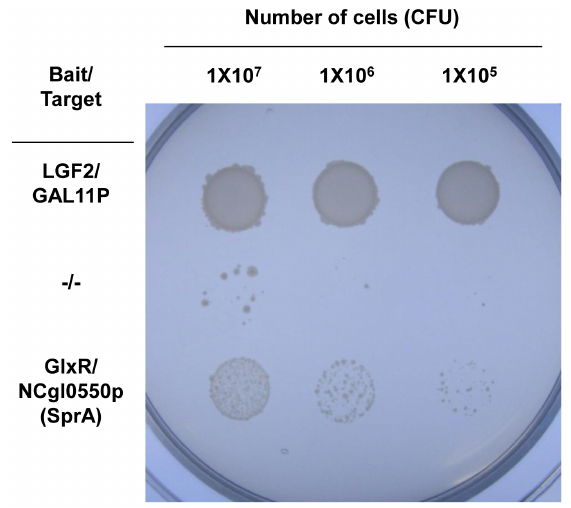
Figure 1. Interaction of GlxR with SprA in the two-hybrid system. The interaction was assayed by monitoring the growth of cells harboring bait and target proteins. Positive control cells harbored well- established interacting proteins such as LGF2 as bait and Gal11p as the target. Negative control cells harbored empty pBT (bait) and pTRG (target) vectors. NCgl0550p, NCgl0550-encoded protein; and CFU,